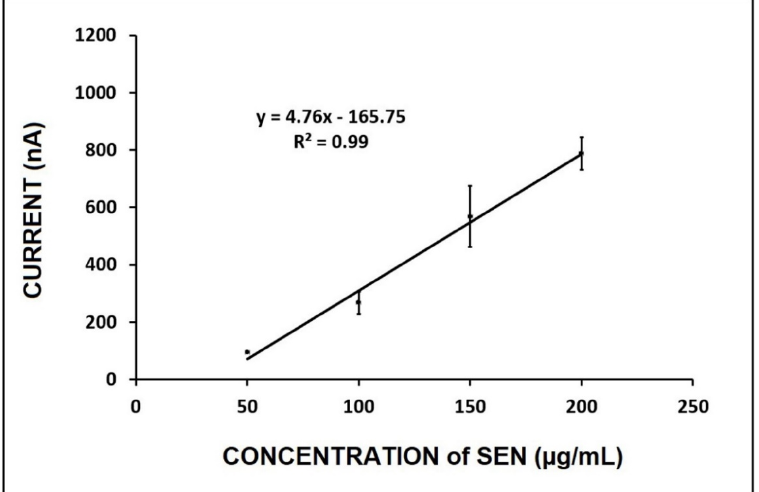
Figure 7. The calibration plot representing the average oxidation signal ( n = 3) in the concentration range of 50–200 µg/mL SEN in 1:100 diluted linden tea sample. range of 50–200 µ g/mL SEN in 1:100 diluted linden tea